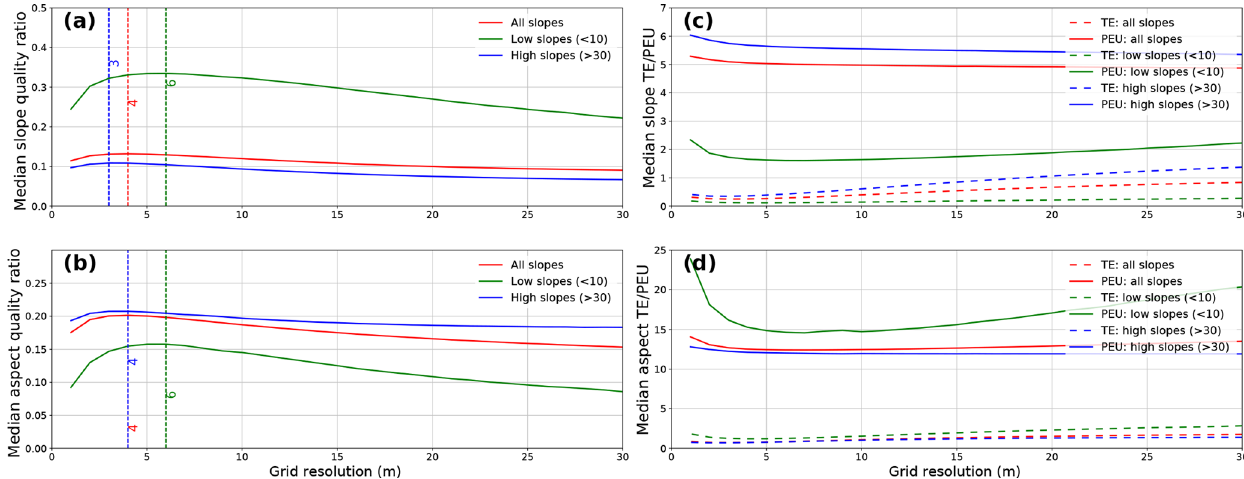
Figure 11. Median QRs for all slopes, low slopes ( < 10), and high slopes ( > 30) across grid resolutions (1–30m). There is a clear trend where low slopes have better slope QRs but worse aspect QRs. The optimal grid resolution for SCI is 4m for both slope and aspect. For interquartile ranges on the QRs, see Fig.